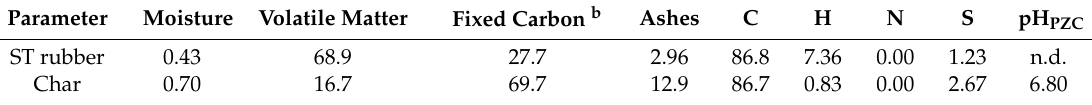
Table 1. Proximate a and elemental a analyses, and pH PZC for both ST rubber and char (% wt).